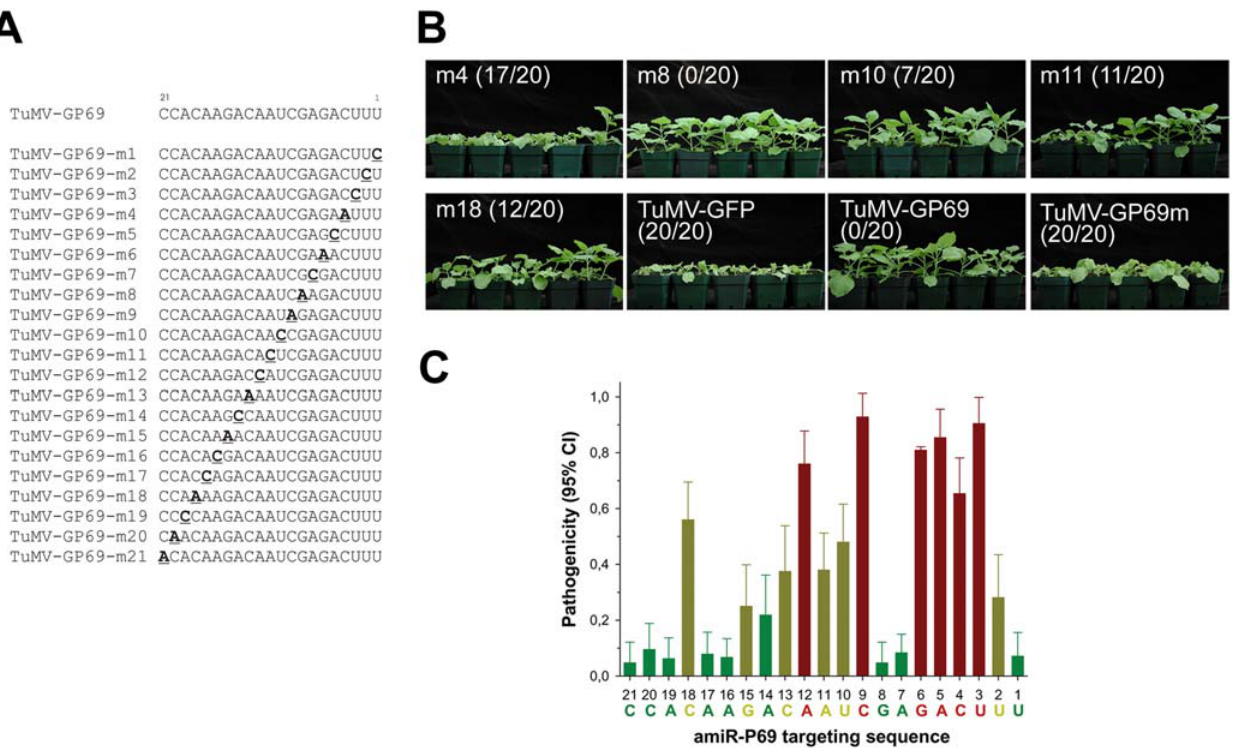
Figure 4. Scanning mutagenesis of the amiR 159 -P69 target site on TuMV-GP69 chimeric virus. (A) A schematic representation of the 21 scanning mutants with substitution of single nucleotide within the 21-nt sequence targeted by amiR 159 -P69. (B) Representative amiR 159 -P69 N. benthamiana plants displaying different degree of breakdown when inoculated with the scanning mutants. The ratio in each panel indicates the number of susceptible amiR 159 -P69 plants amongst 20 plants challenged. (C) A summary of critical positions within the amiR 159 -P69 target site. The 21-nt RNA sequence is shown on the x -axis. Numbers below the sequence indicate the positions of amiR 159 -P69 starting from the 5 9 end. The degree of resistance breakdown was represented as the percent of inoculated plants with viral disease symptoms. Red bars represent critical positions for resistance; yellow bars represent positions of moderate importance; green bars represent positions of minimal influence in resistance-breakdown.